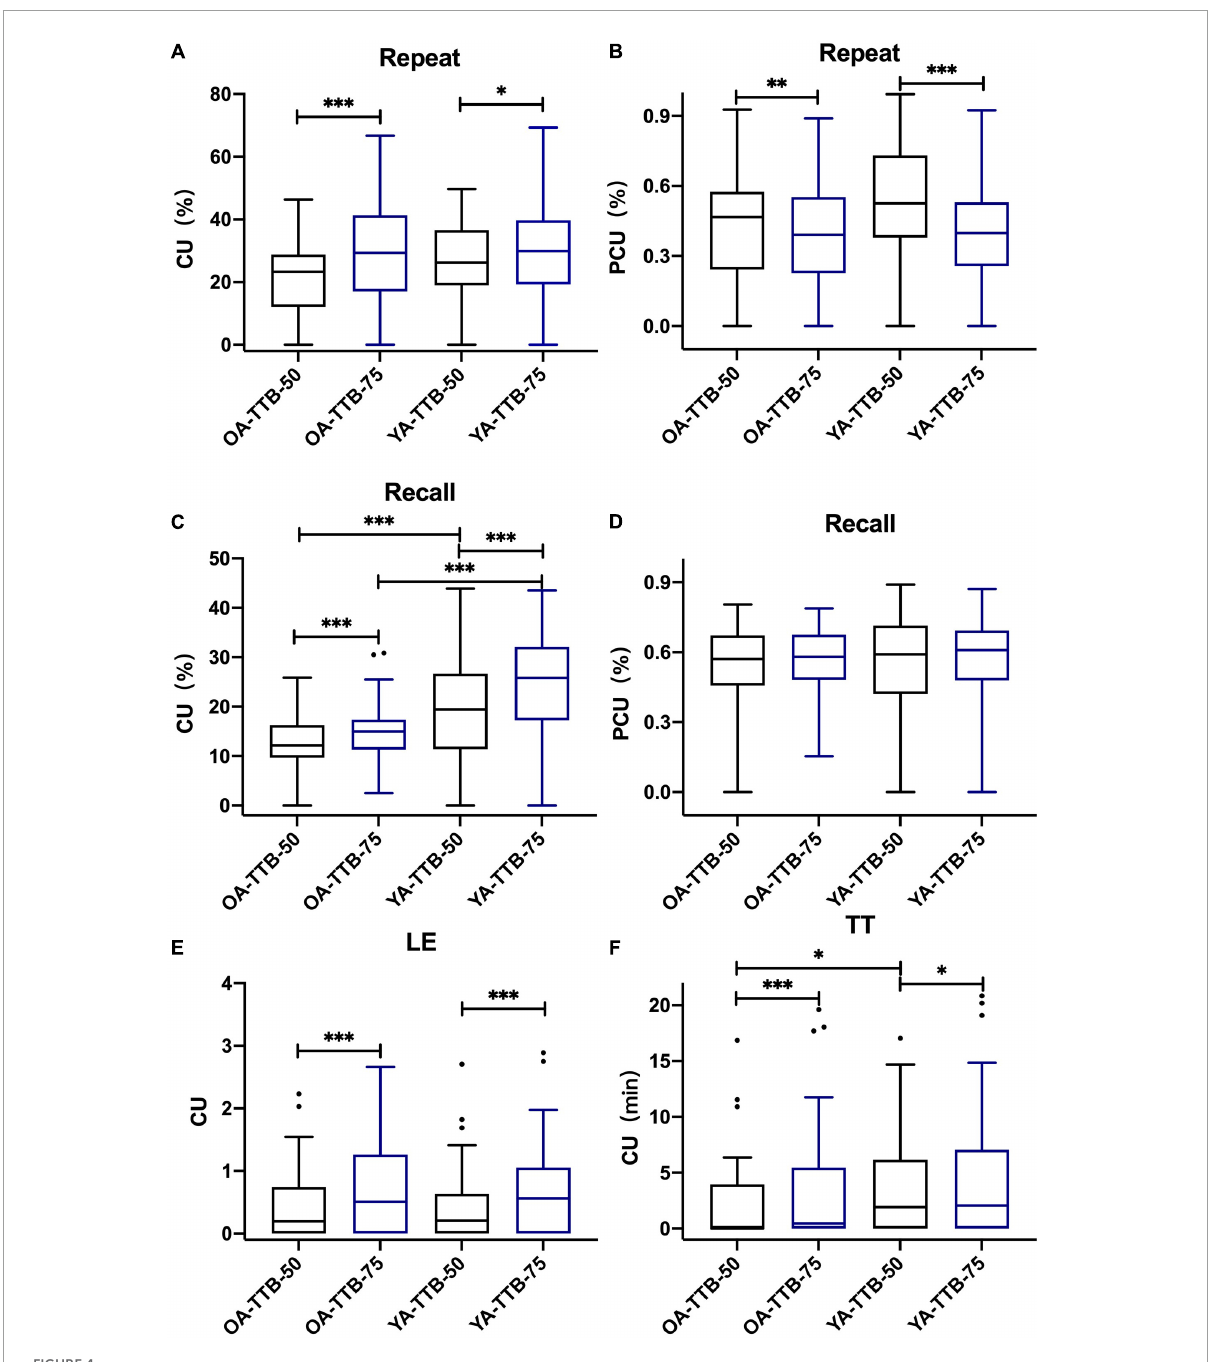
FIGURE4 P/CU performances under two SRTs in two age groups in TTB. (A) CU (Repeat 50% / 75% ), (B) PCU (Repeat 50% / 75% ), (C) CU(Recall 50% / 75% ), (D) PCU (Recall 50% / 75% ), (E) CU (LE 50% / 75% ), (F) CU (TT 50% / 75% ). All the figures were Boxplot. The top and bottom lines of a column represented the maximum and minimum values of the data, respectively. The top and bottom lines of the box represented the third quartile and the first quartile, respectively, and the line in the middle of the box represents the median of the data. Black circles represented outliers. ∗ P < 0.05, ∗∗ P < 0.01, ∗∗∗ P <